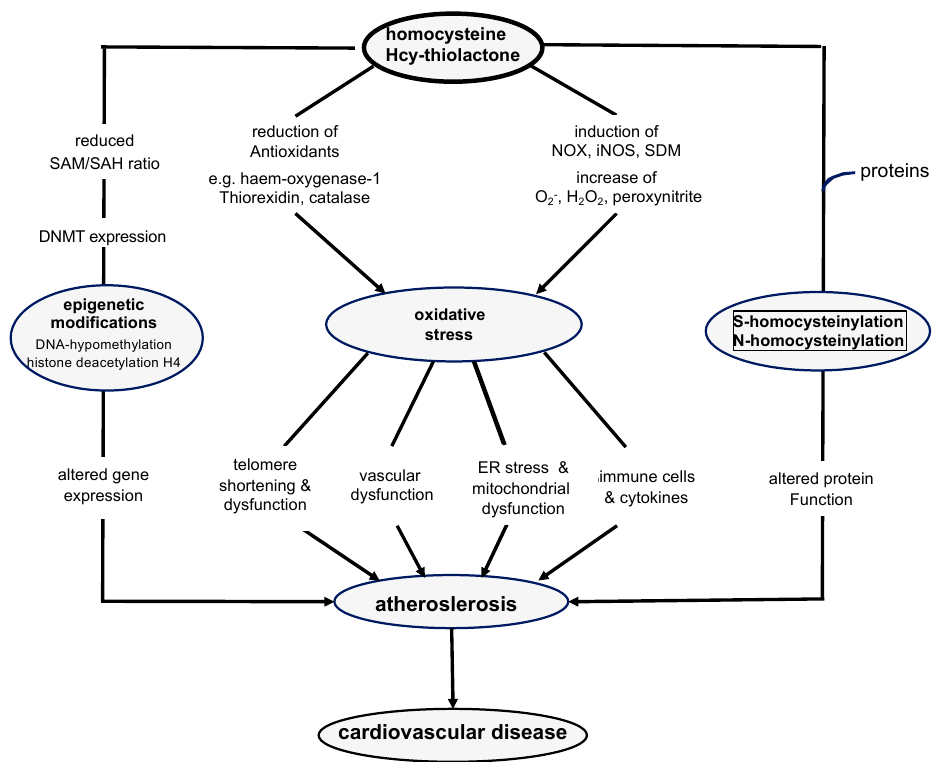
Figure 2. Pathomechanisms in hyperhomocysteinemia—oxidative stress, epigenetic modifications, altered protein function—causing atherosclerosis and cardiovascular disease. Hcy, homocysteine; SAH, S-adenosylhomocysteine; SAM, S-adenosylmethionine; DNMT, DNA methyl transferase; NOX, nicotinamide adenine dinucleotide phosphate (NADPH) oxidase; iNOS, inducible nitric oxide synthase; SDM, superoxide dismutase; O 2 − , superoxide; H 2 O 2 , hydrogen peroxide; ER, endoplasmatic reticulum.